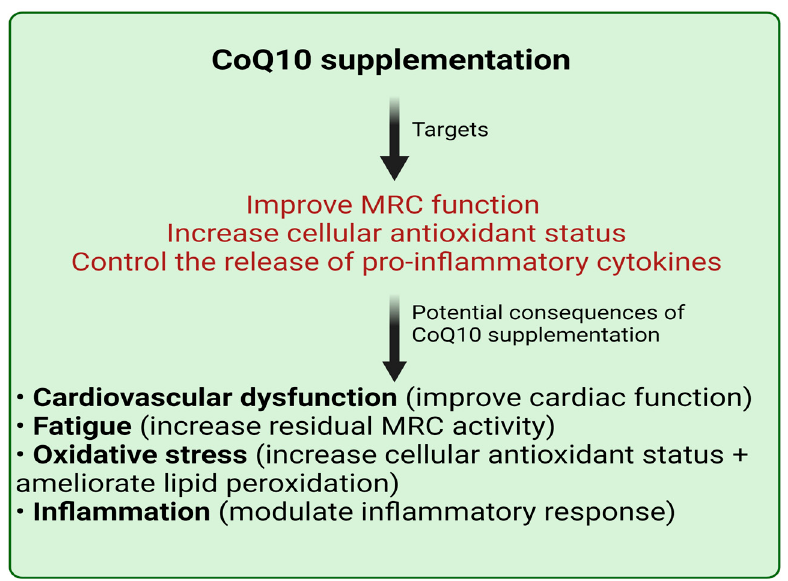
Figure 1. The potential targets and consequences of CoQ10 supplementation in Lyme disease. CoQ10: coenzyme Q10; MRC: mitochondrial respiratory